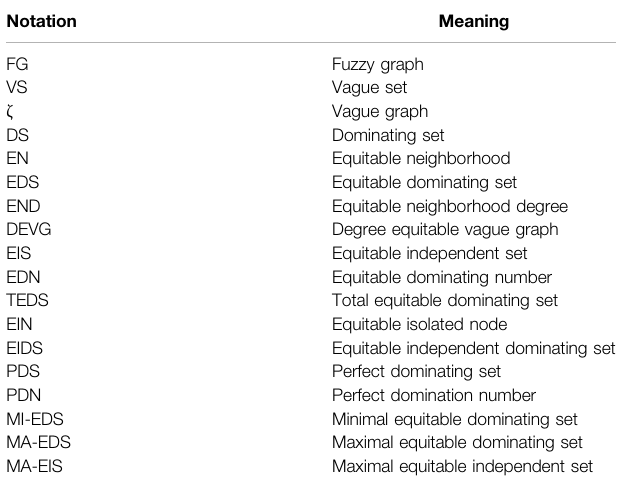
TABLE 1 | Some basic notations.